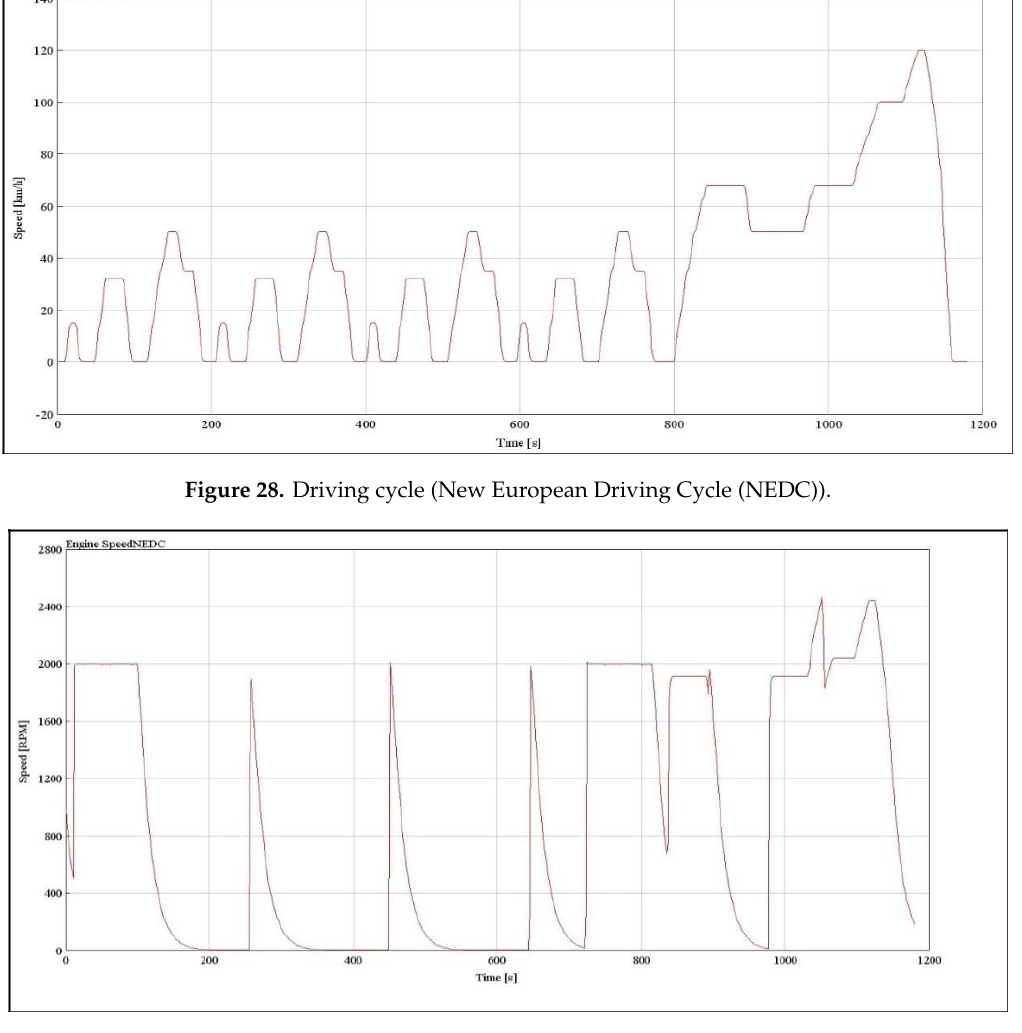
Figure 29. Engine speed (NEDC).